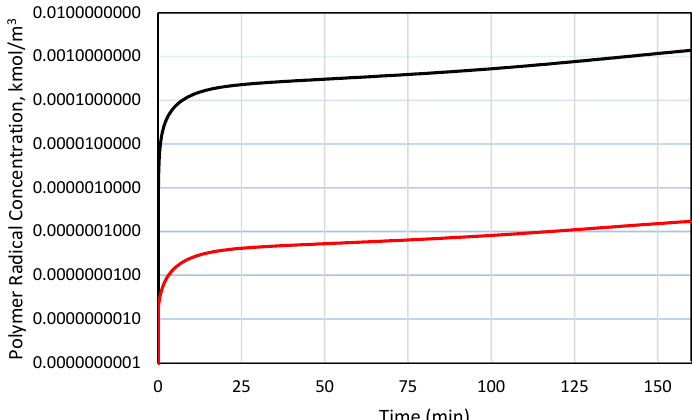
Figure 10. Calculated profiles of polymer radical concentration in the free radical polymerization of MMA using DTL1: overall polymer radicals (black solid line) and polymer radicals excluding dormant polymer P s DTL • (red solid line).